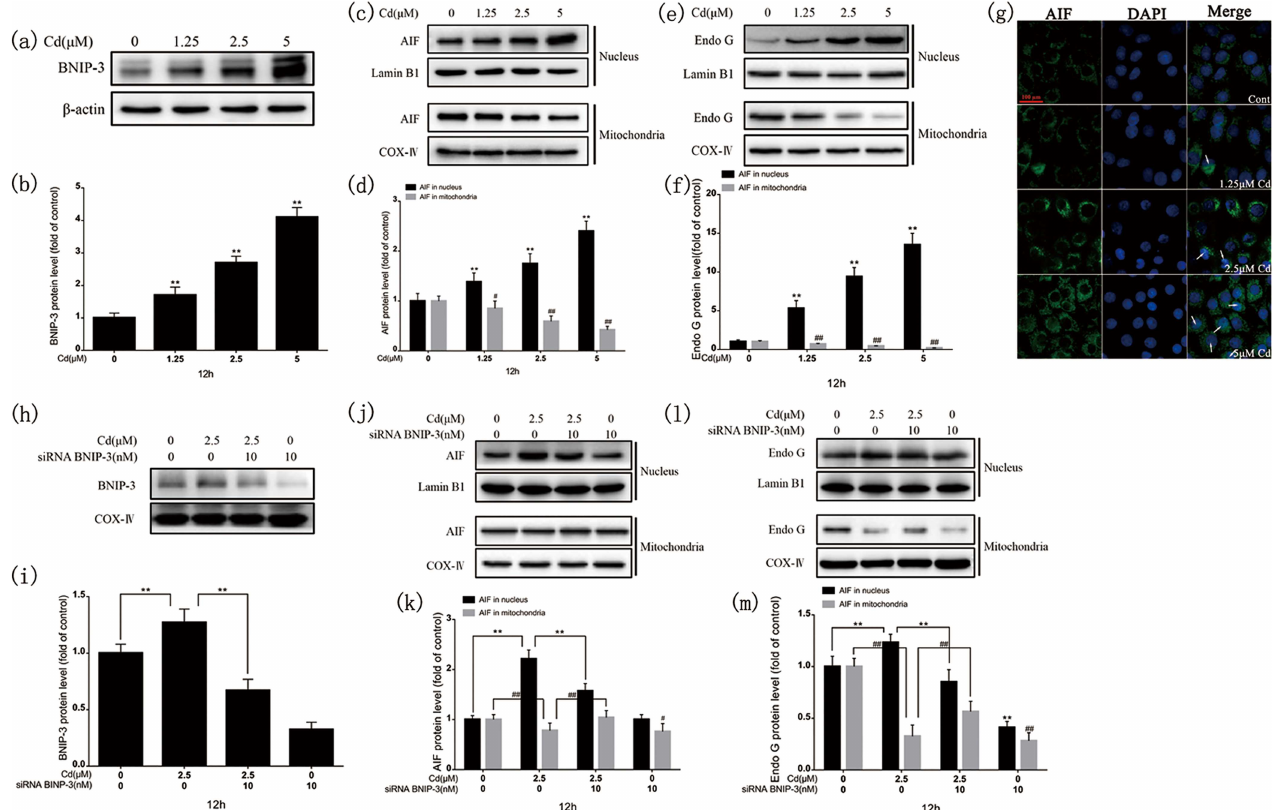
Fig 4. Cadmium induced BNIP-3 expressionand cytoplasmic AIF and Endo G translocation to the nucleus after 12-h cadmium treatment. (a, c, e) Representative images of BNIP-3, AIF, and Endo G western blots. (b, d, f) Quantitative analysisof BNIP-3, AIF, and Endo G; grayscaleof the control was set at 1. (g) Cadmiumtreatment (12 h) triggeredAIF nucleartranslocation dose-dependently. rPT cells were stainedwith anti-AIF antibodiesand Alexa Fluor 488–labeledgoat anti-rabbitIgG. AIF nuclear translocation was evaluatedunder fluorescence microscopy with DAPI staining.Scale bar: 50 μ m. Effects of BNIP-3 silencingon changesin BNIP-3 expressionand cytoplasmicAIF and Endo G translocation to the nucleusafter 12-h cadmium treatment in the absenceor presenceof BNIP-3 small interferingRNA (siRNA). (h, j, l) Representative images of BNIP- 3, AIF, and Endo G western blots. (i, k, m) Quantitative analysisof BNIP-3, AIF, and Endo G; grayscaleof the control was set at 1. Results are from three independent experiments (mean ± SD, n = 3). ** P < 0.01, # P < 0.05, and ## P < 0.01 as comparedto control.